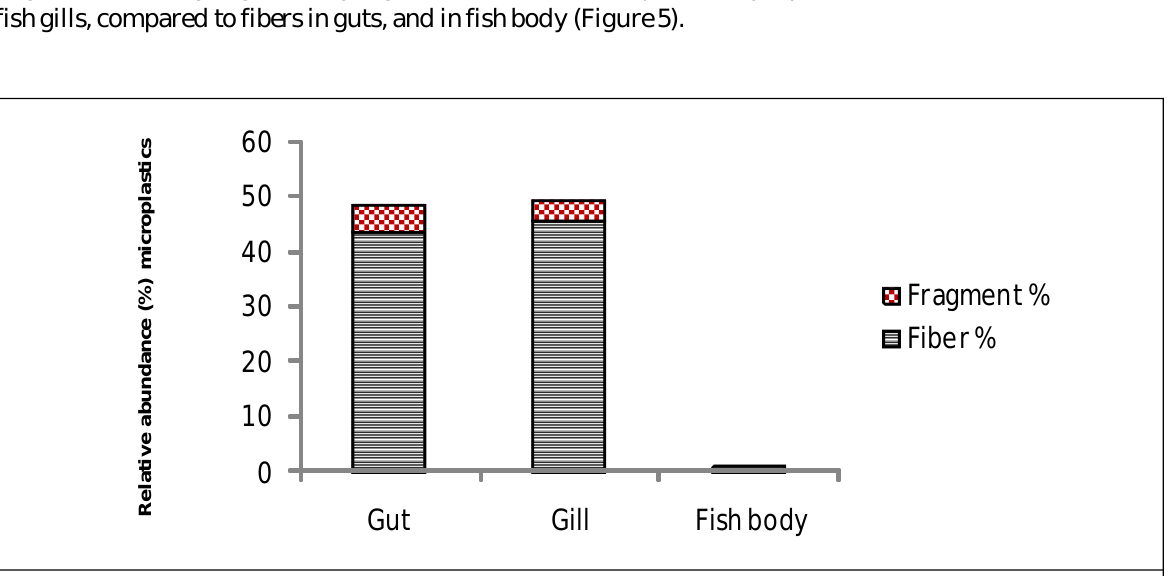
Figure 5: Mean percentage concentration of microplastic shapes observed in organs of different fish species from the creeks along the Kenya